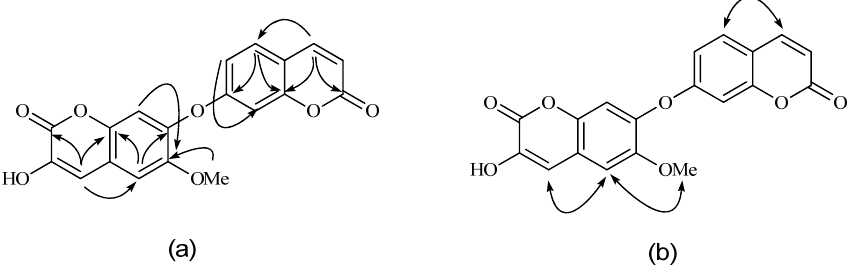
Figure 2. Key HMBC (a), and key NOESY (b) correlations of compound 1